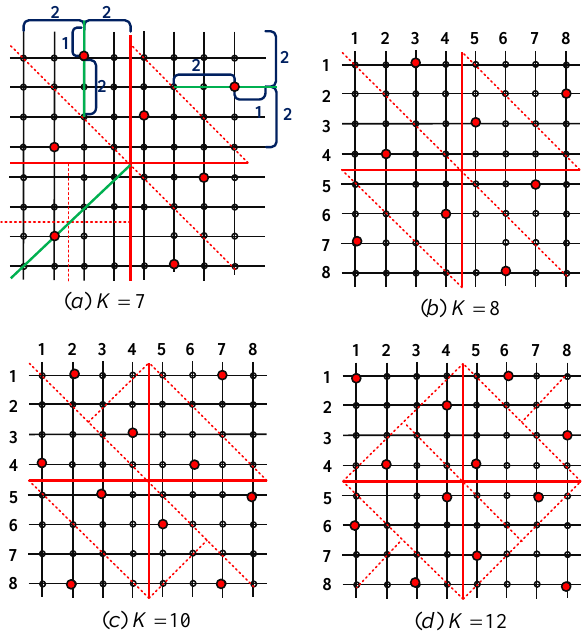
Figure 14. Center rule (K > 4): ( a ) K = 7; ( b ) K = 8; ( c ) K = 10; ( d ) K = 12.